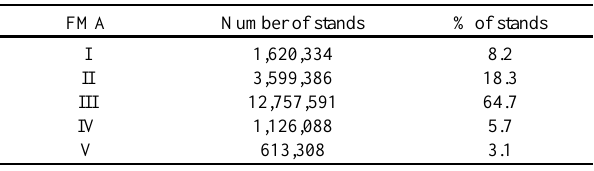
Table 4 . Classification of forest management descriptions to forest management approaches (FMAs). (Forest management descriptions from national inventory plots. FMAs I: nature- reserve; II: close-to-nature; III: combined objective; IV: even-